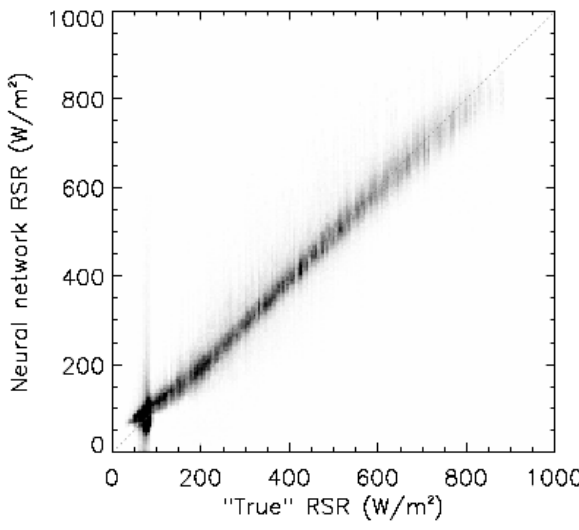
Fig. 8. Comparison between “true” SW irradiance and RRUMS, the neural network retrieval.